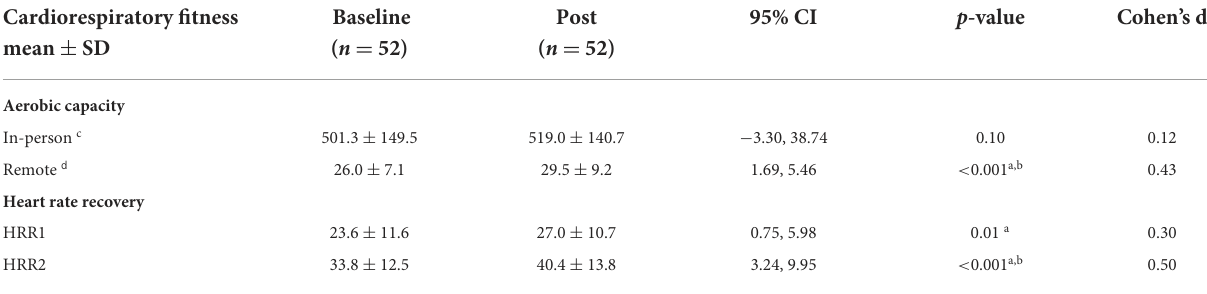
TABLE 3 Cardiorespiratory fitness.